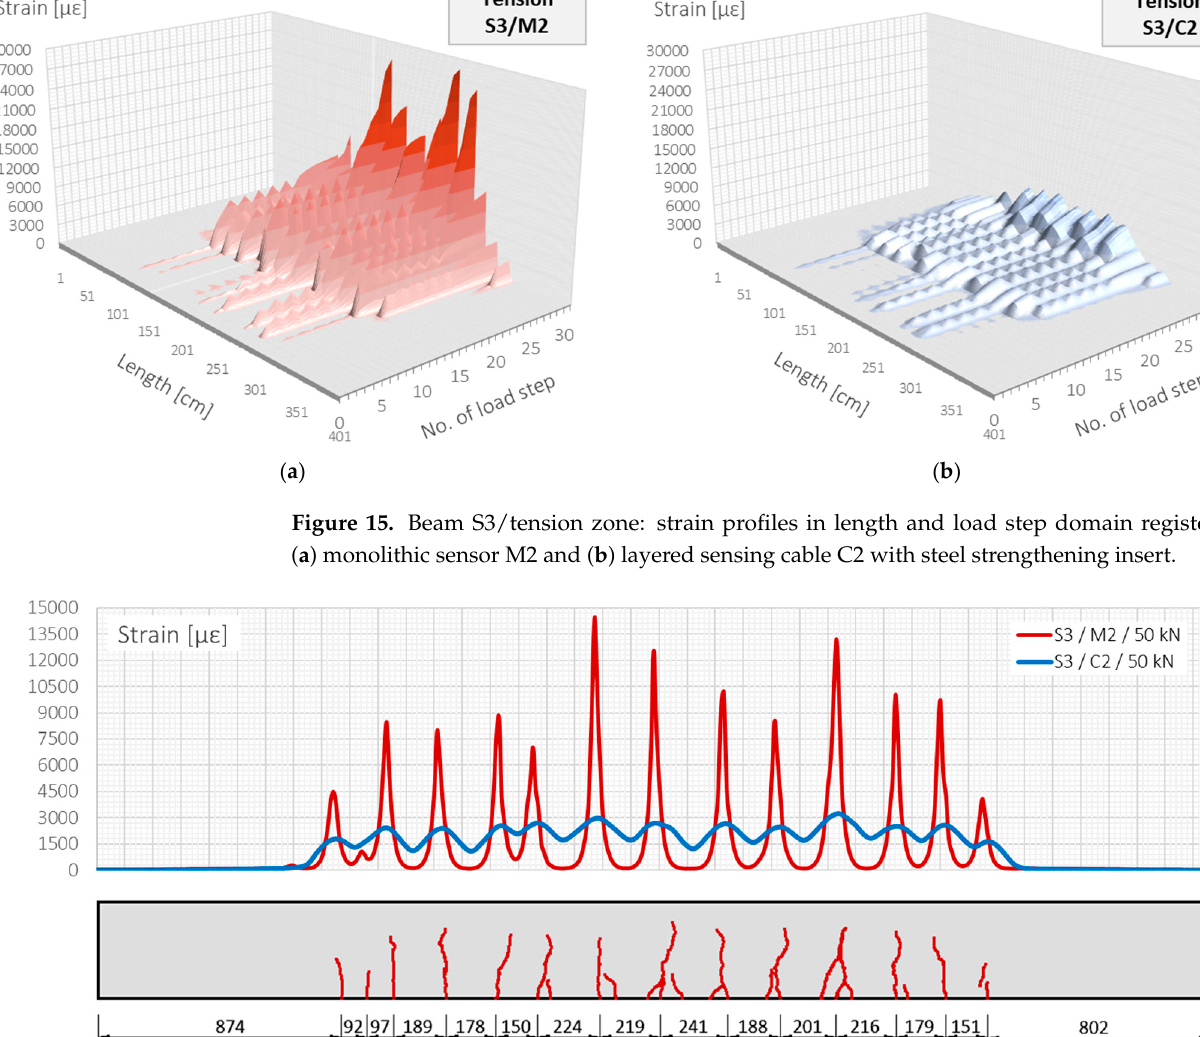
Figure 16. Strain profiles over length measured by monolithic sensor M2 and layered cable C2 (beam S3, load step no. 26, force = 50 kN).